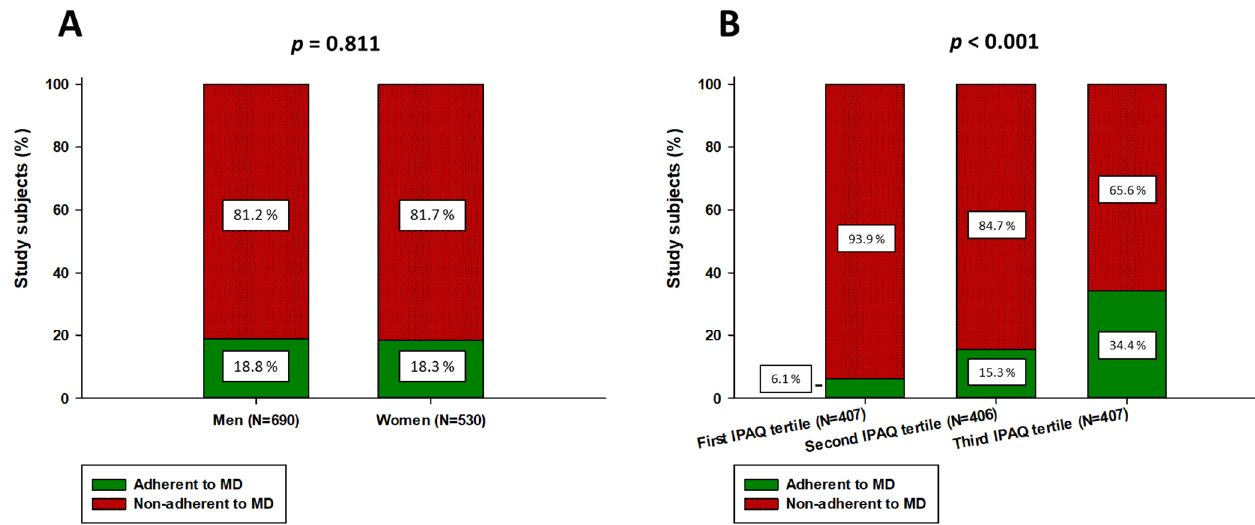
Figure 4. Differences in the adherence to the MD between ( A ) gender and ( B ) tertiles of the IPAQ-SF results. The chi-square test was used for analysis.